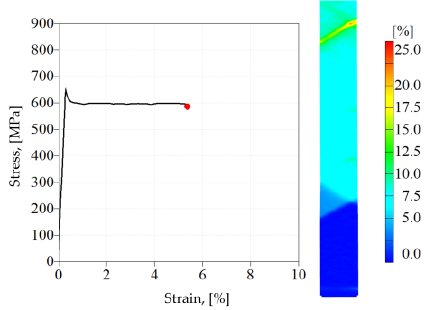
Figure 3. Failure in tensile test before reaching homogenous forming state (TH620—transversal direction).